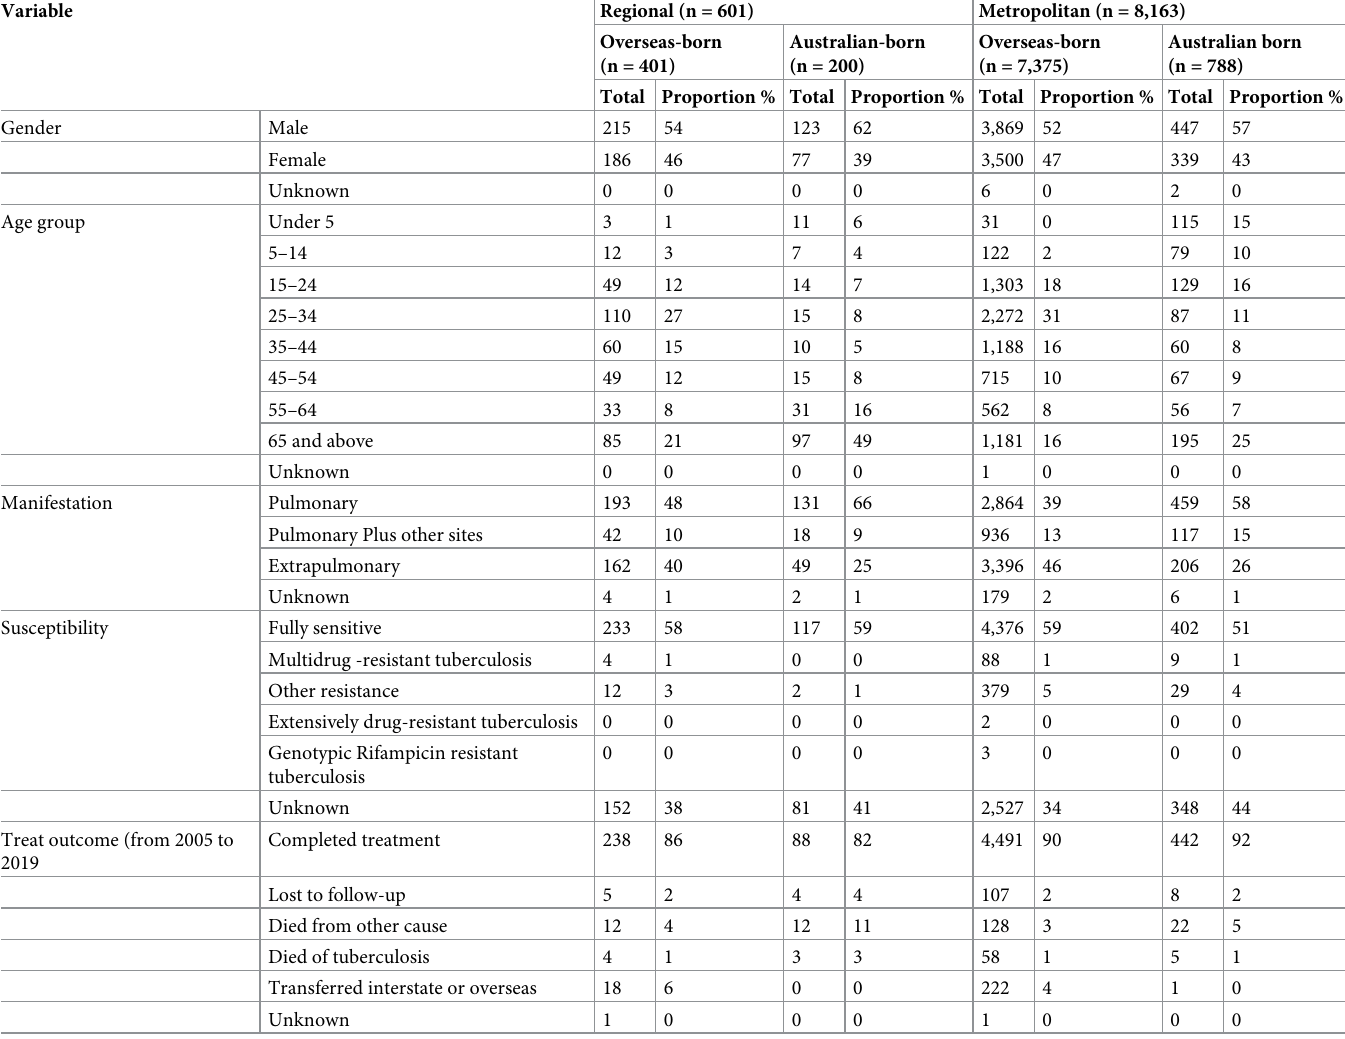
Table 1. Characteristics of the notified cases of tuberculosis in Victoria from 1995 to